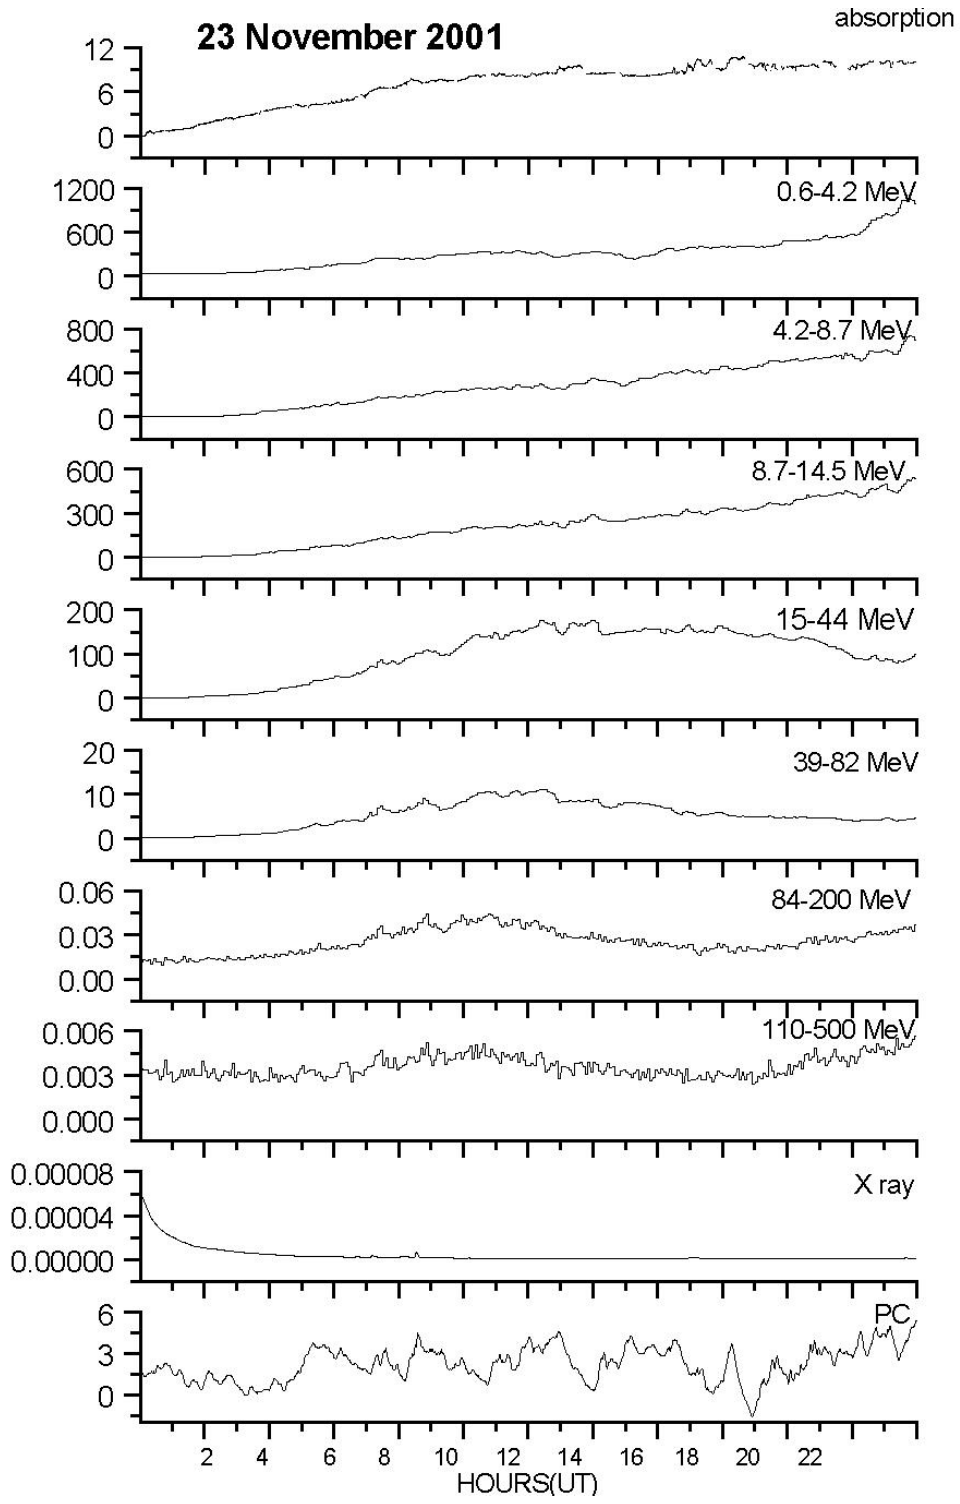
Fig. 7. As Fig. 1, but for 23